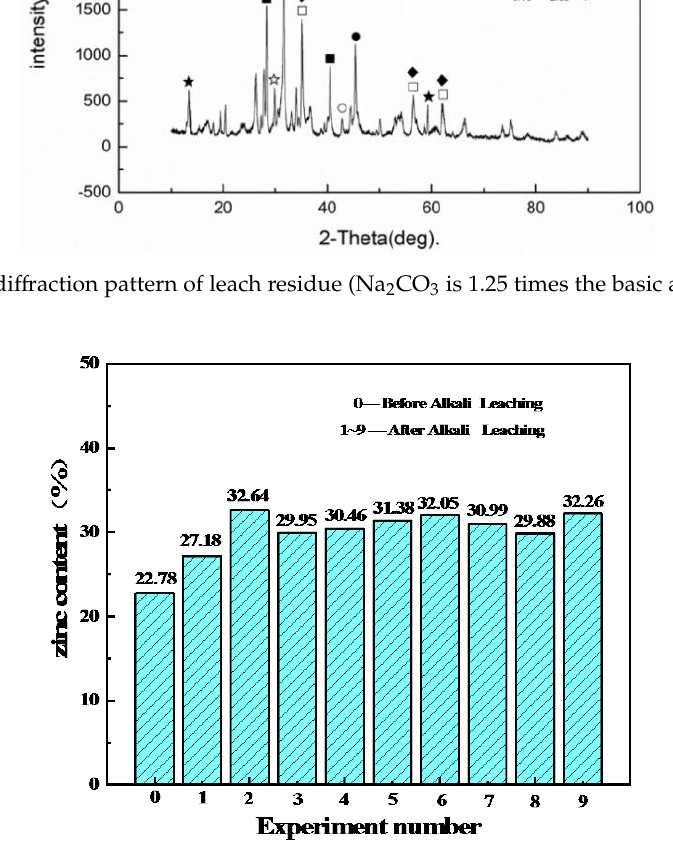
Figure 9. Zinc content in leaching residue for different conditions in the alkali leaching experiment.